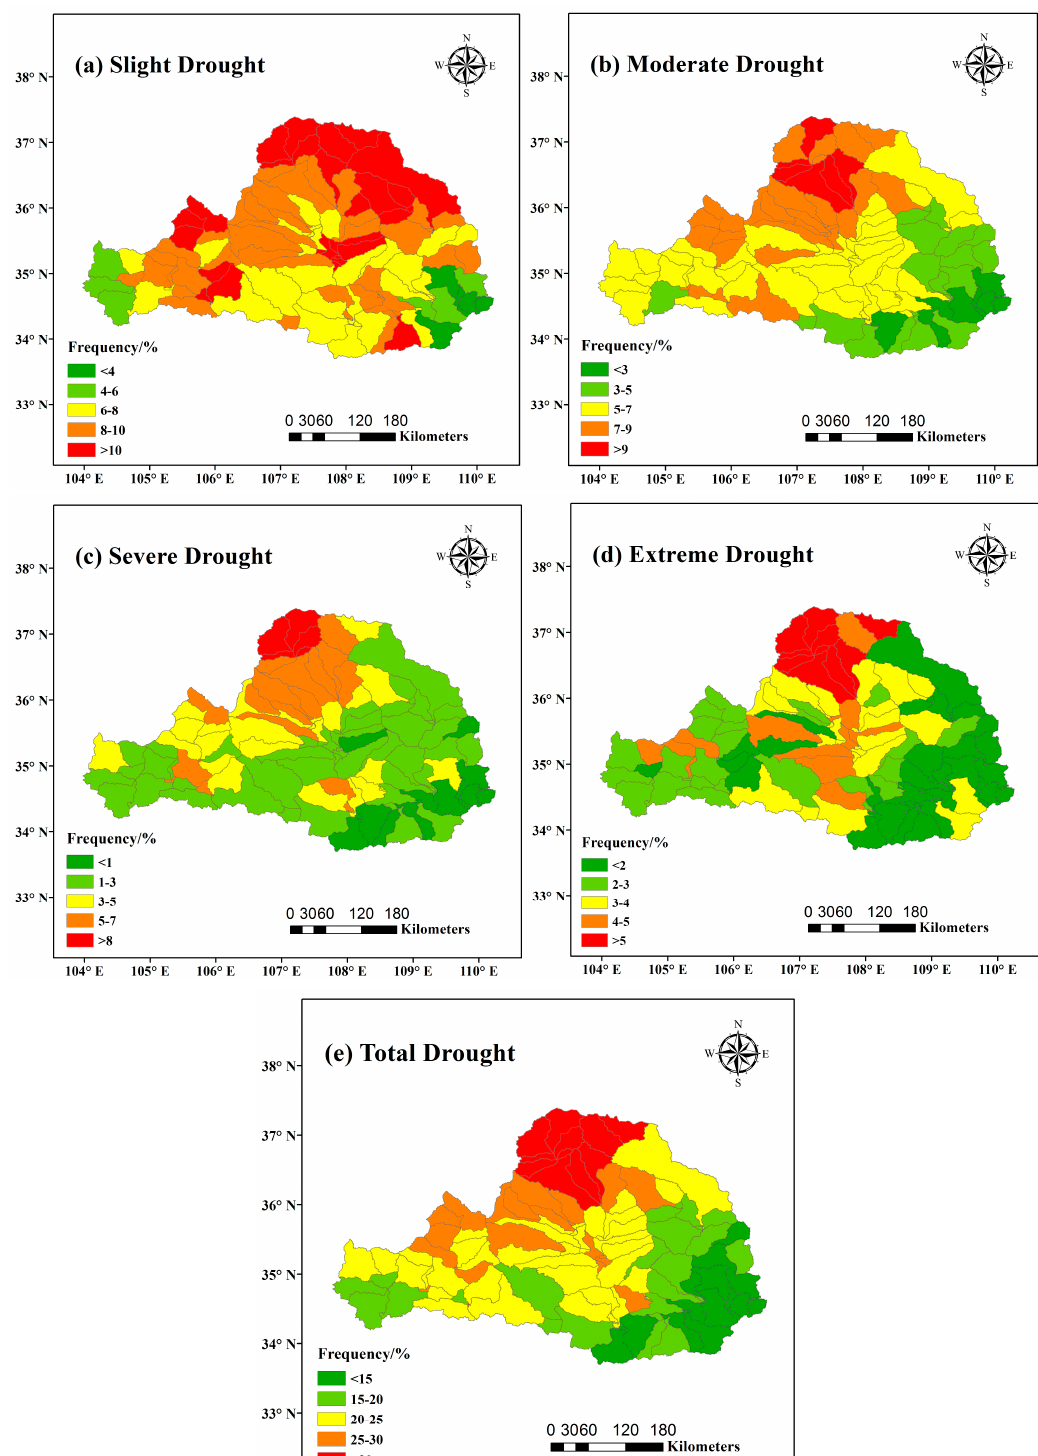
Figure 9. Spatial patterns of drought frequency of different levels of drought severity based on PDSI_SWAT: ( a ) Slight drought; ( b ) Moderate drought; ( c ) Severe drought; ( d ) Extreme drought and ( e ) Total drought.